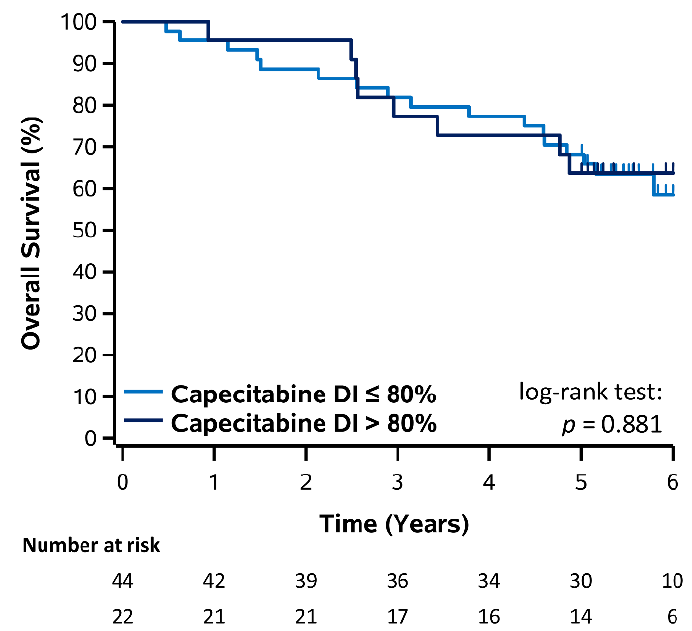
Figure 4. Kaplan–Meier plot of OS stratified by DI of capecitabine in patients receiving capecitabine.